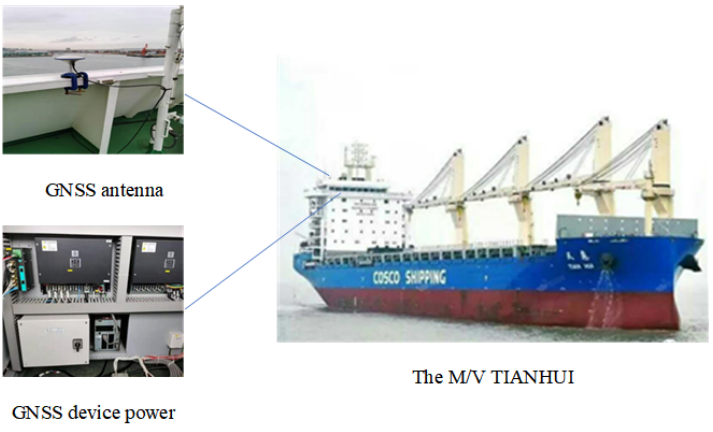
Figure 2. M/V TIANHUI and location of GNSS